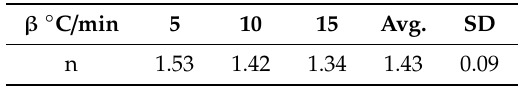
Table 2. Avrami parameters calculated at each heating rate.